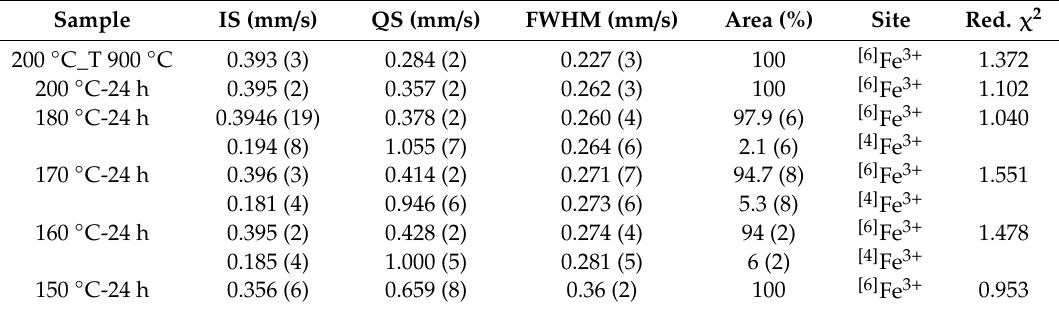
Table 2. 57 Fe Mössbauer parameter for the aegirines, synthesized in this study.